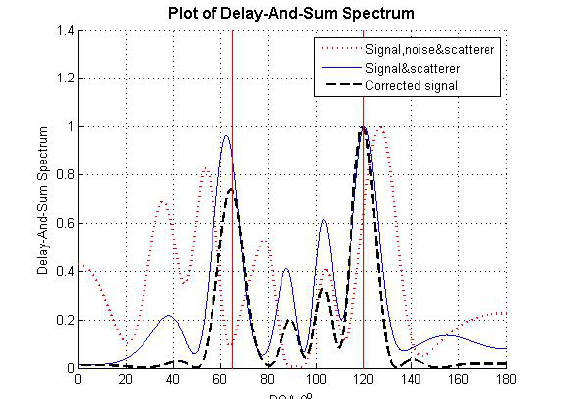
Figure 20: DOA spectrum for case 4